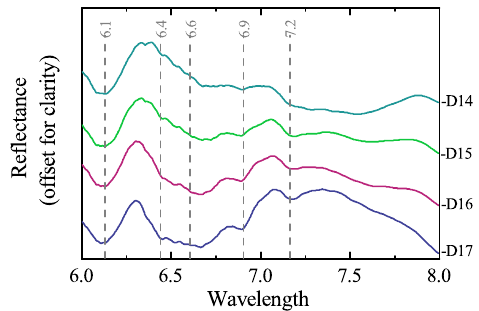
Figure 6. Diffuse reflectance spectra of diatomite ore samples with variable content of CaCO 3 : D14 = 6.29 wt %, D15 = 10.9 wt %, D16 = 16.4 wt %, D17 = 24.4 wt